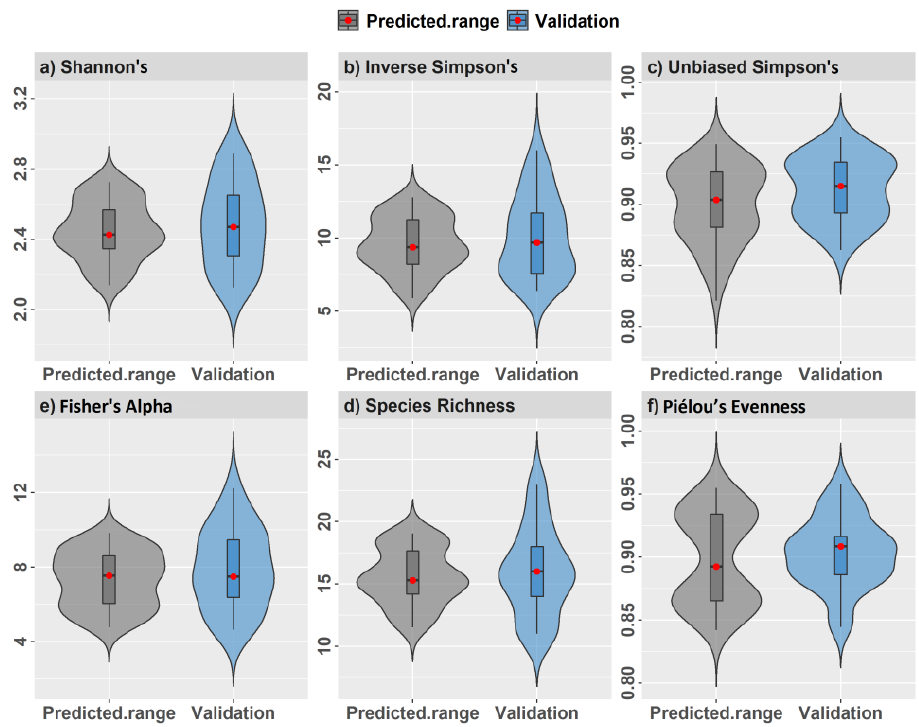
Figure 10. Observed α-diversity index values compared with the range of predicted pixel values from the combined spatial model for regularly spaced 0.10 ha validation plots.